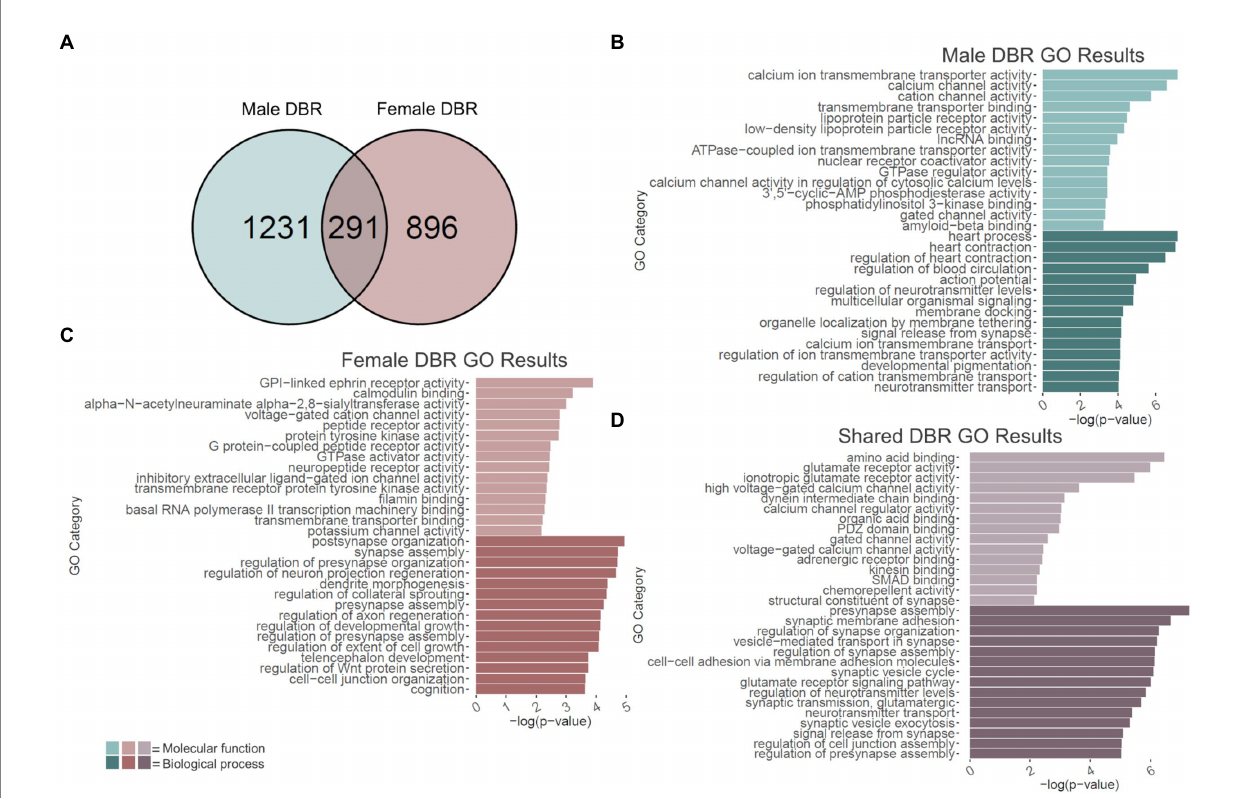
FIGURE 5 GO analysis of genes showing differentially bound H3K36me3 regions (DBR). (A) Number of genes showing differential binding of H3K36me3 due to adolescent binge ethanol in males and females at p < 0.05. Fisher’s exact test determined male and female gene overlap to be significant, p = 2.9e-131. (B) GO analysis of genes showing differential binding of H3K36me3 unique to males. (C) GO analysis of genes showing differential binding of H3K36me3 unique to females. (D) GO analysis of genes showing differential binding of H3K36me3 that are shared between males and